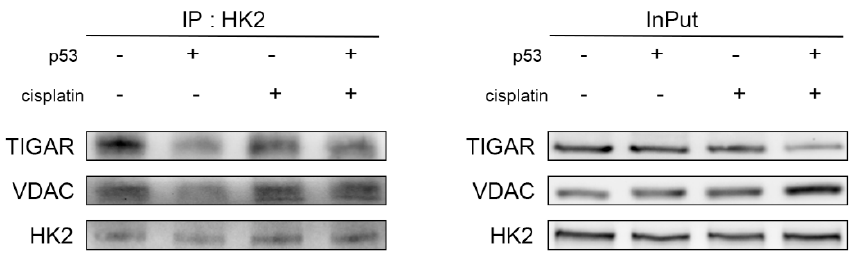
Figure 5. Combination treatment of cisplatin with p53 reduced the localization of the TIGAR-HK2 complex to the mitochondria. Immunoprecipitation was used to detect the binding of HK2 to TIGAR and VDAC after A549 cells were treated and expressed as the mean ± SD; n = 3.